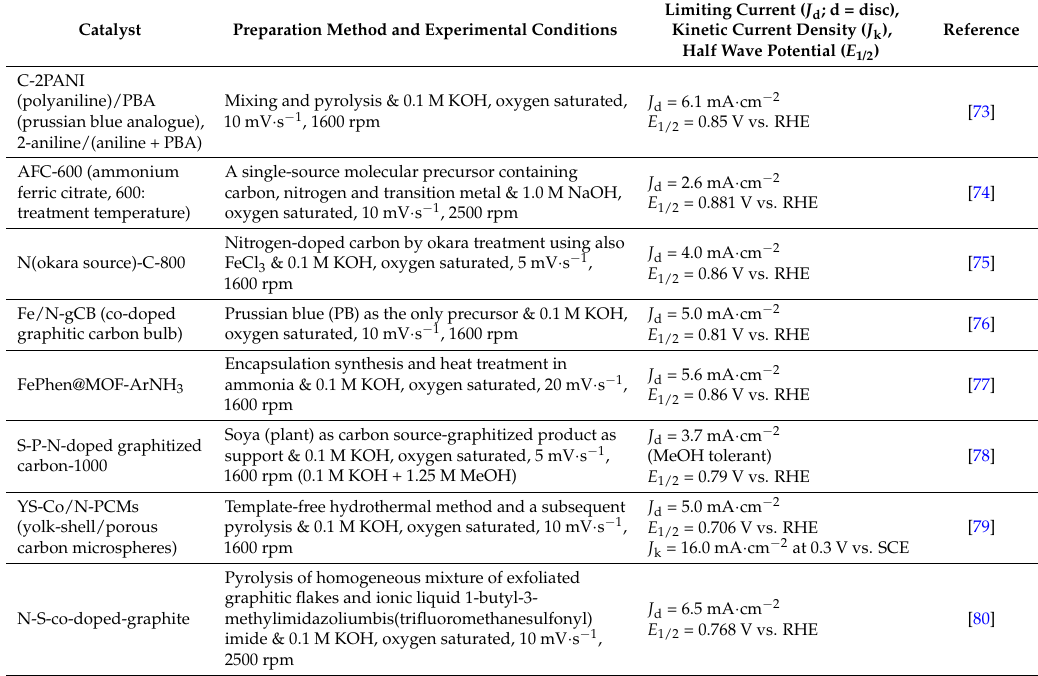
Table 3. Non-precious alternative precursors’ ORR